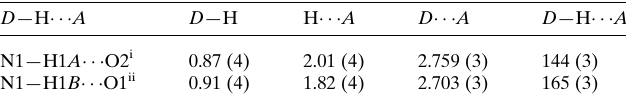
Table 1 Hydrogen-bond geometry (A˚ , (cid:4) ).